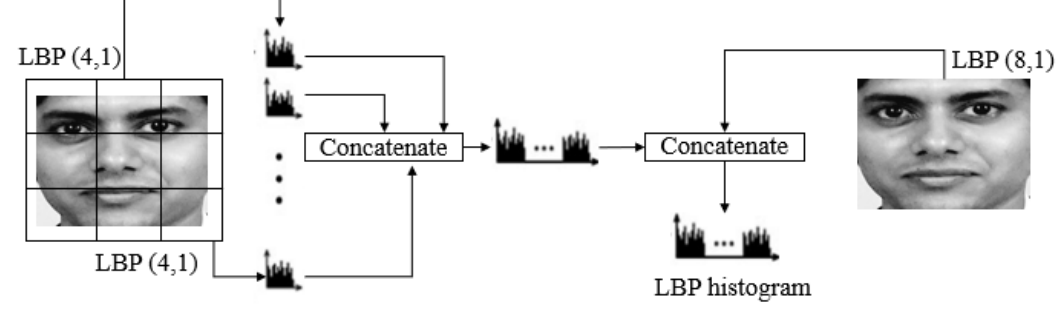
Figure 3. Facial representation in low-resolution